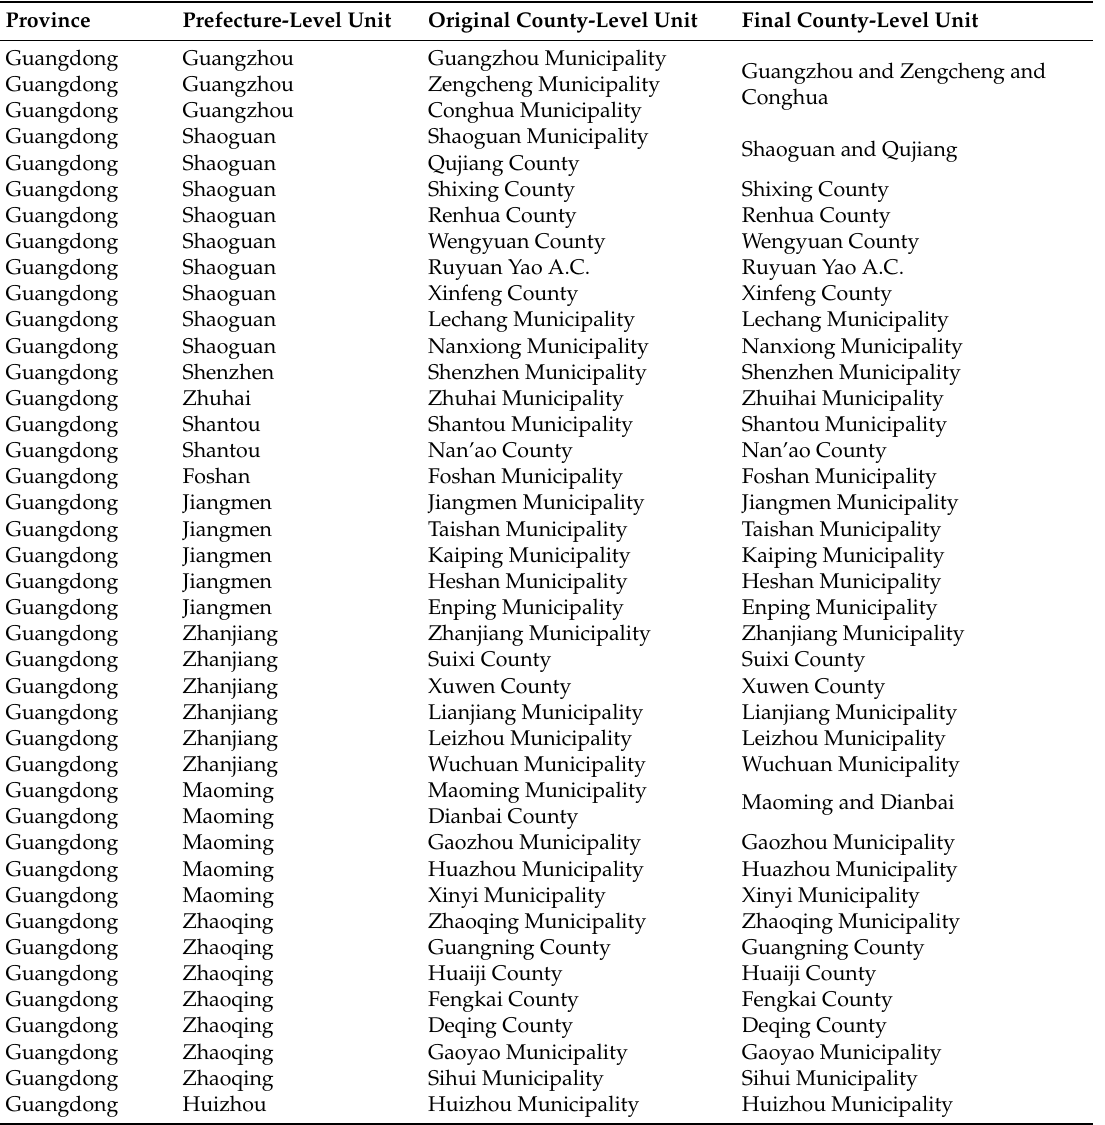
Table A1. A list of the prefecture-level and county-level administrative units for South China. The county-level units we used are in the last